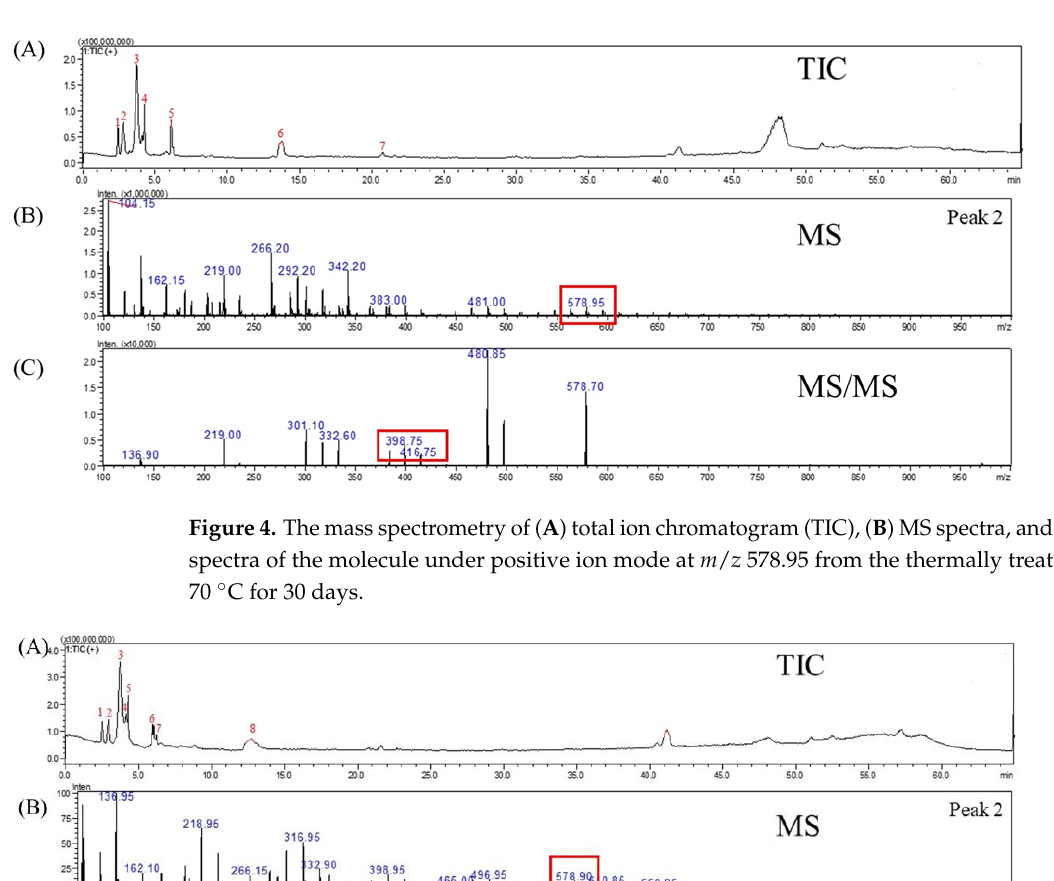
radish at 70 °C for 12 days.